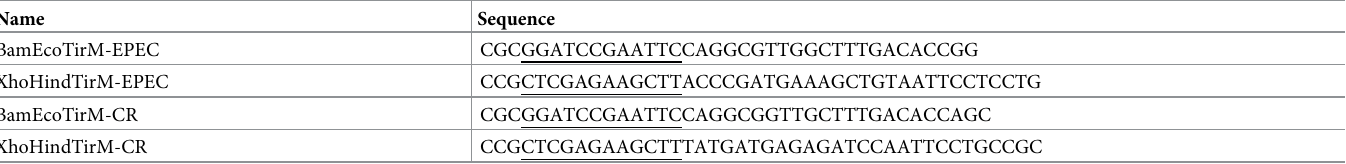
Table 2. Oligonucleotides used in this